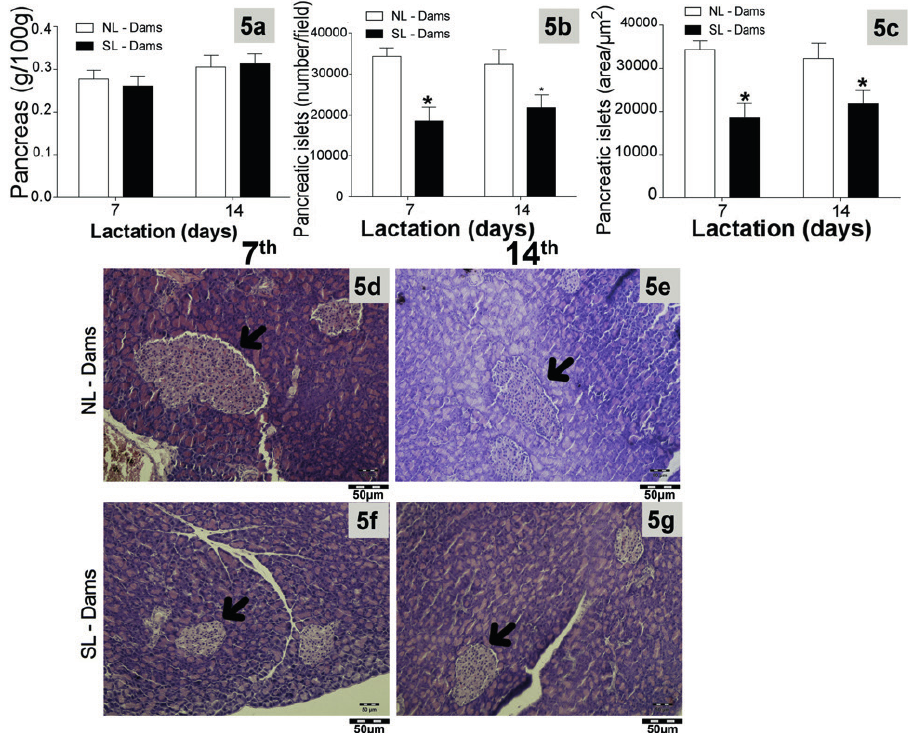
Figure 5 - Histological analysis of the endocrine pancreas from lactating SL-dams and NL-dams during different lactational phases. The values are expressed as mean ± Standard Error of the Mean (n= 9-12 animals/group). The symbol above bars indicates a significant difference (p<0.05) between the groups (Two-way ANOVA with uncorrected Fisher´s LDS: * SL versus NL; a 7 th day of lactation; b 14 th day of lactation). The arrows in the image indicate the pancreatic